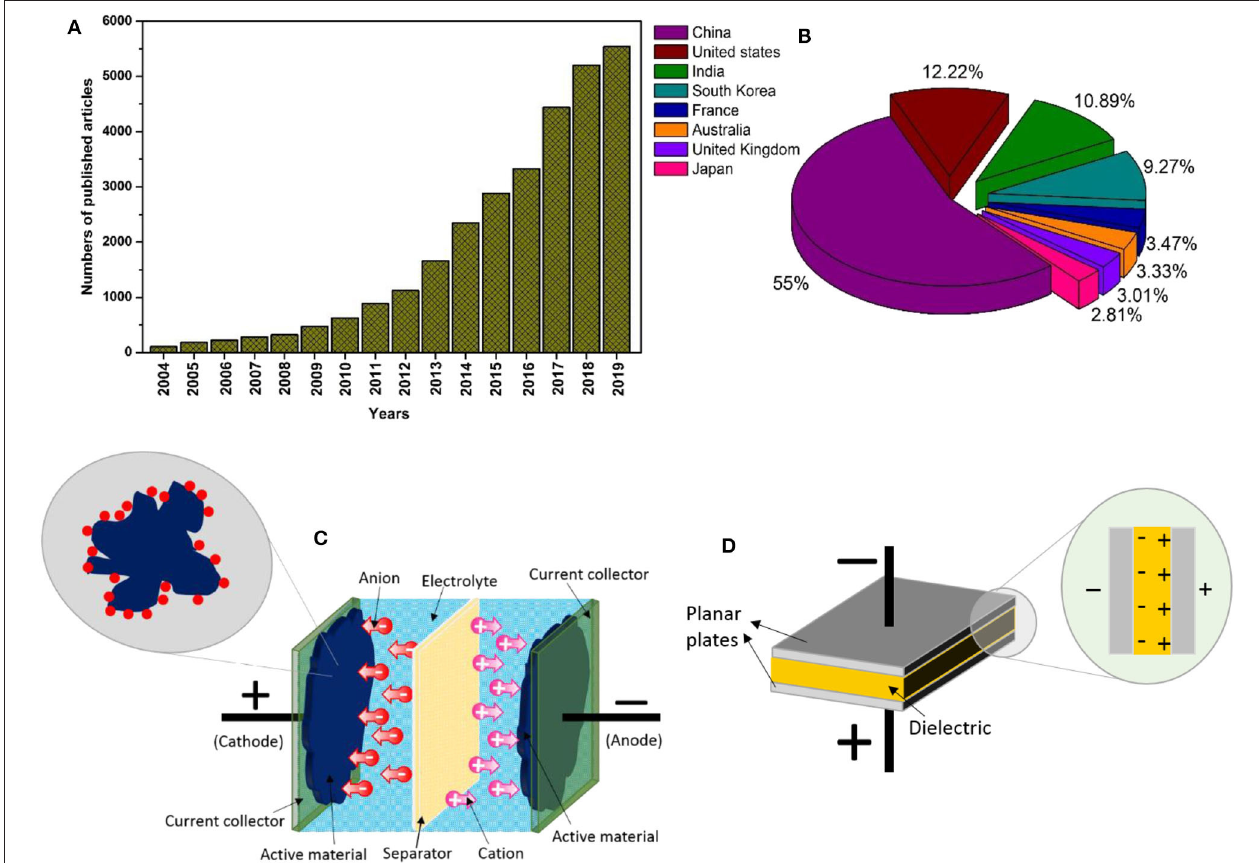
FIGURE 1 | (A) Trends in the number of articles published on supercapacitor, (B) proportions of overall publications by countries from 2004 to 2019 using the keyword “supercapacitor.” (Data is collected from Scopus on 30 November 2019.), (C) schematic diagram of electrochemical supercapacitor, and (D) conventional